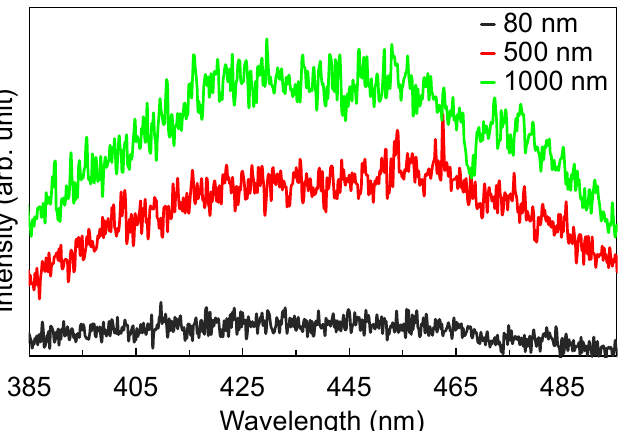
Figure 9. PL emission spectra of the TiO 2 films. The increase in the PL intensity coincides with the decrease in the transparency of the thicker films.